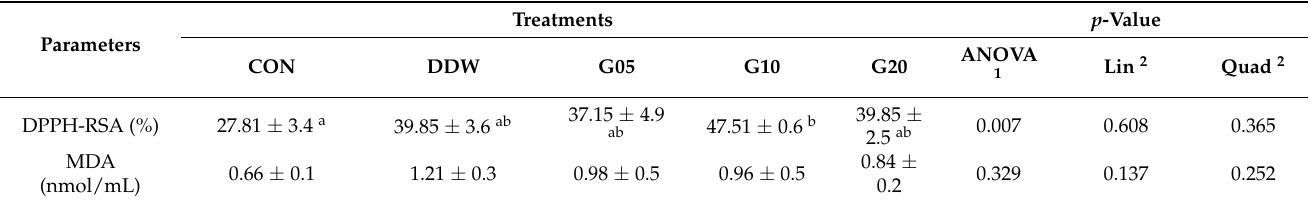
Table 4. Effects of in ovo injection of GABA on oxidative stress markers in blood biochemicals of hatchlings. Parameters